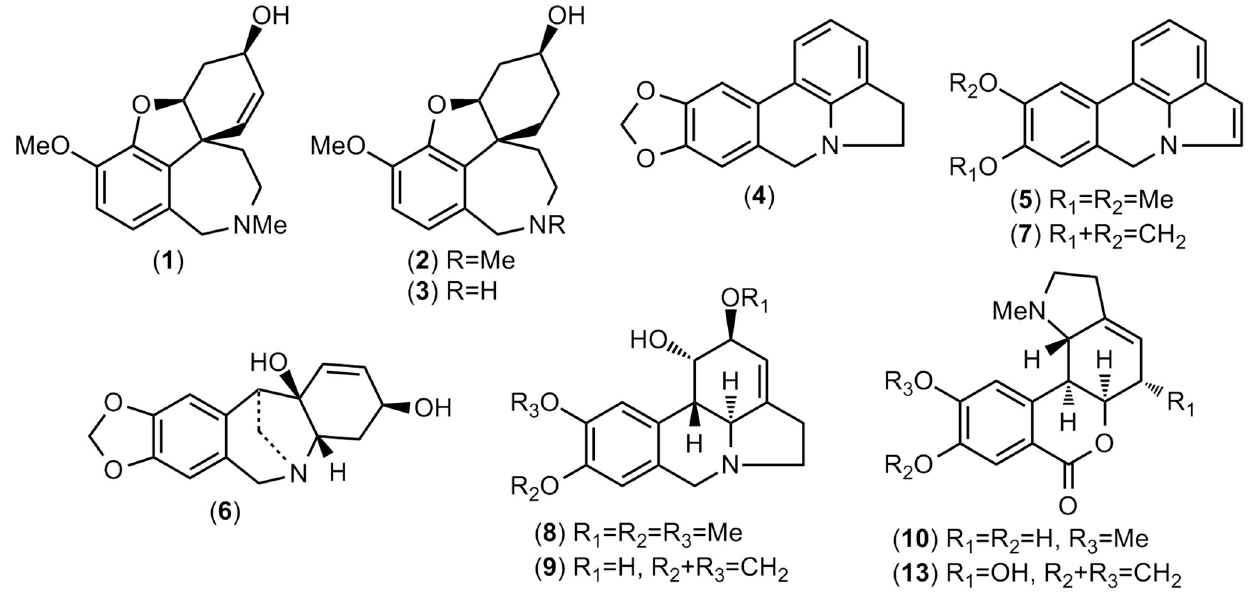
Figure 1. Amaryllidaceae alkaloids identified in Ismene amancaes bulbs by GC ‐ MS.